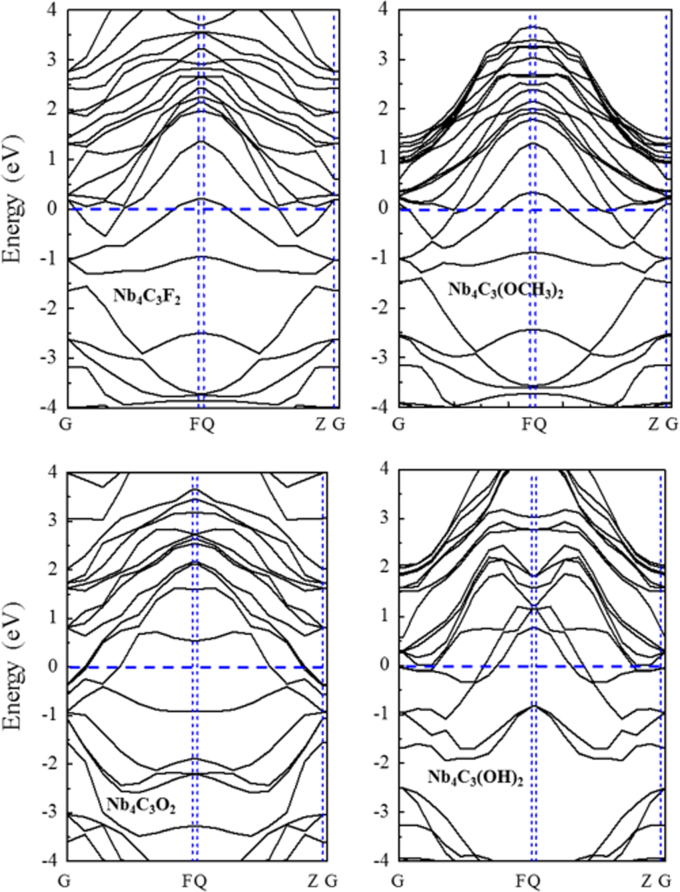
Band structures of Nb4C3Z2 (Z = F, O, OH, OCH3).